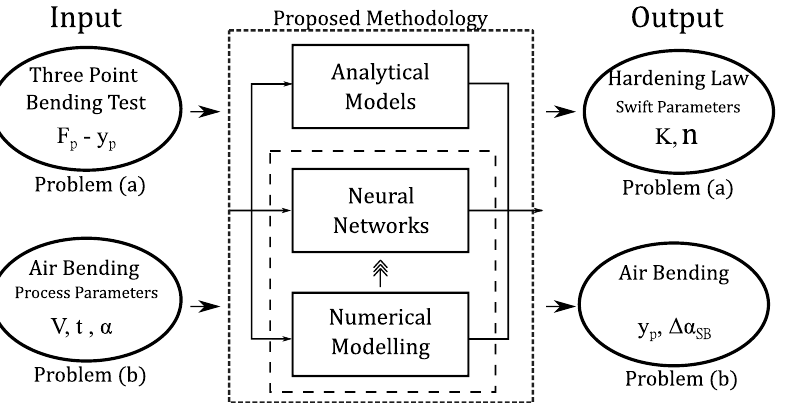
Figure 8. Schematic representation of the main objectives and the proposed methodology for solving problems (a) and